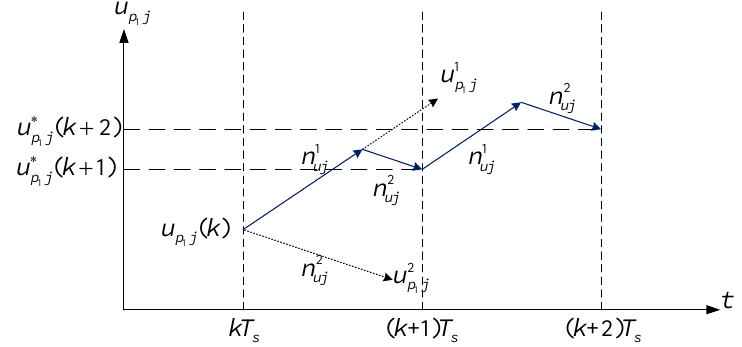
Figure 3. Principle of one step Modulated Model Predictive Control (M 2 PC).